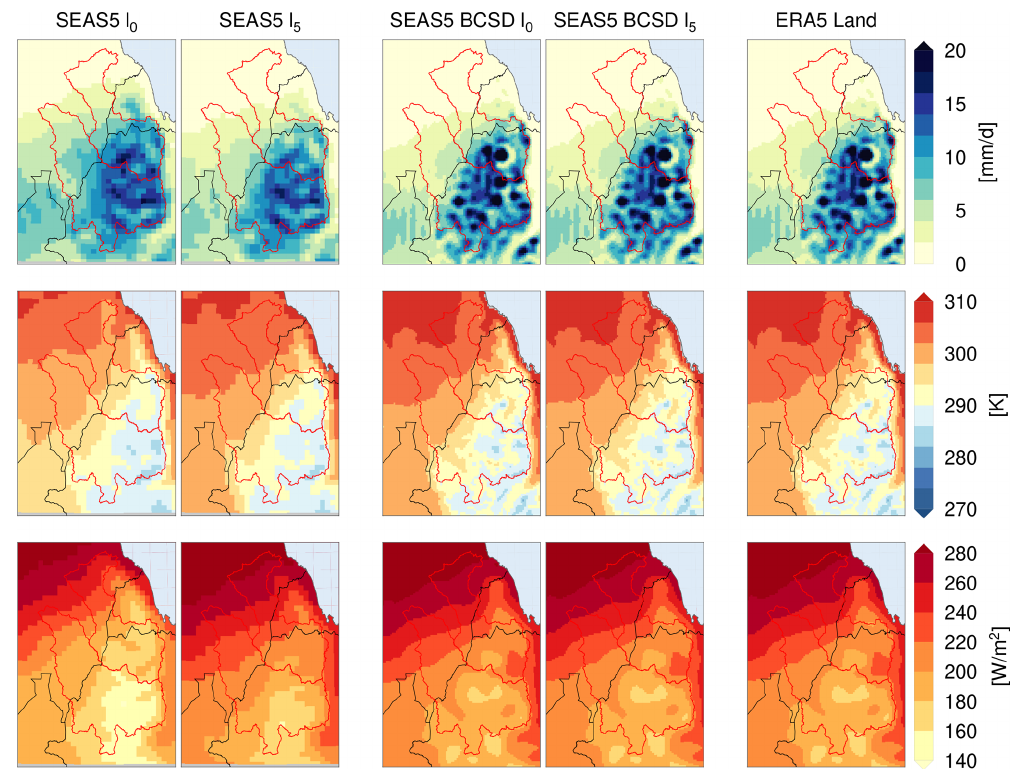
Figure 6. Average July predictions from SEAS5 lead 0 and 5 (first two columns), SEAS5 BCSD lead 0 and 5 (center columns), and reference values from ERA5-Land (right column) for precipitation (top row), average temperature (middle row) and radiation (bottom row) for the African Domain